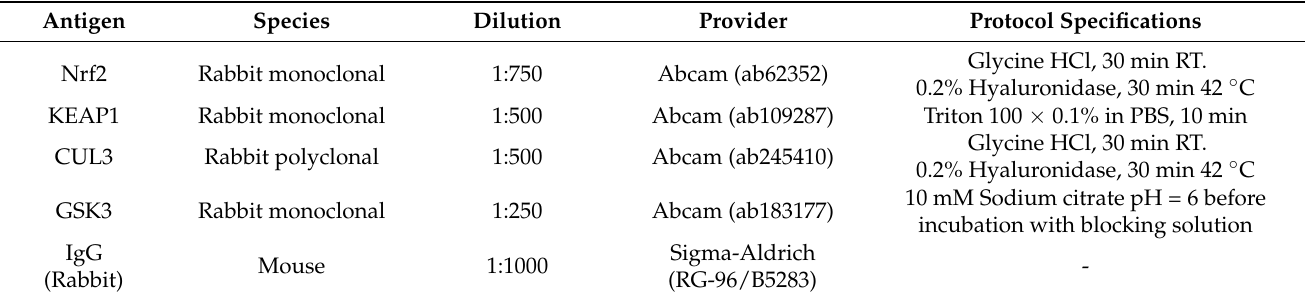
Table 3. Primary and secondary antibodies used in the immunohistochemical studies performed, showing the dilutions used and the protocol